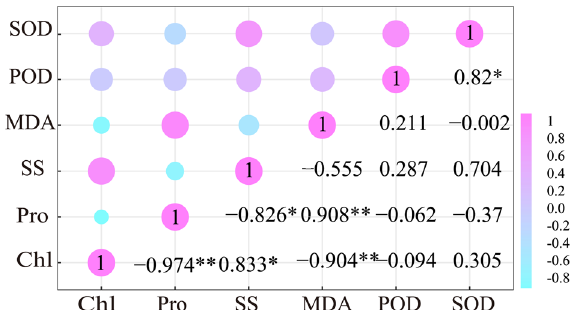
Figure 3. Correlation analysis among physiological properties under gradient of Hg stress. The introduction of Chl, MDA, POD, Pro, SOD and SS have showed in Fig. 3. Significance levels are denoted with * p < 0.05, ** p < 0.01.